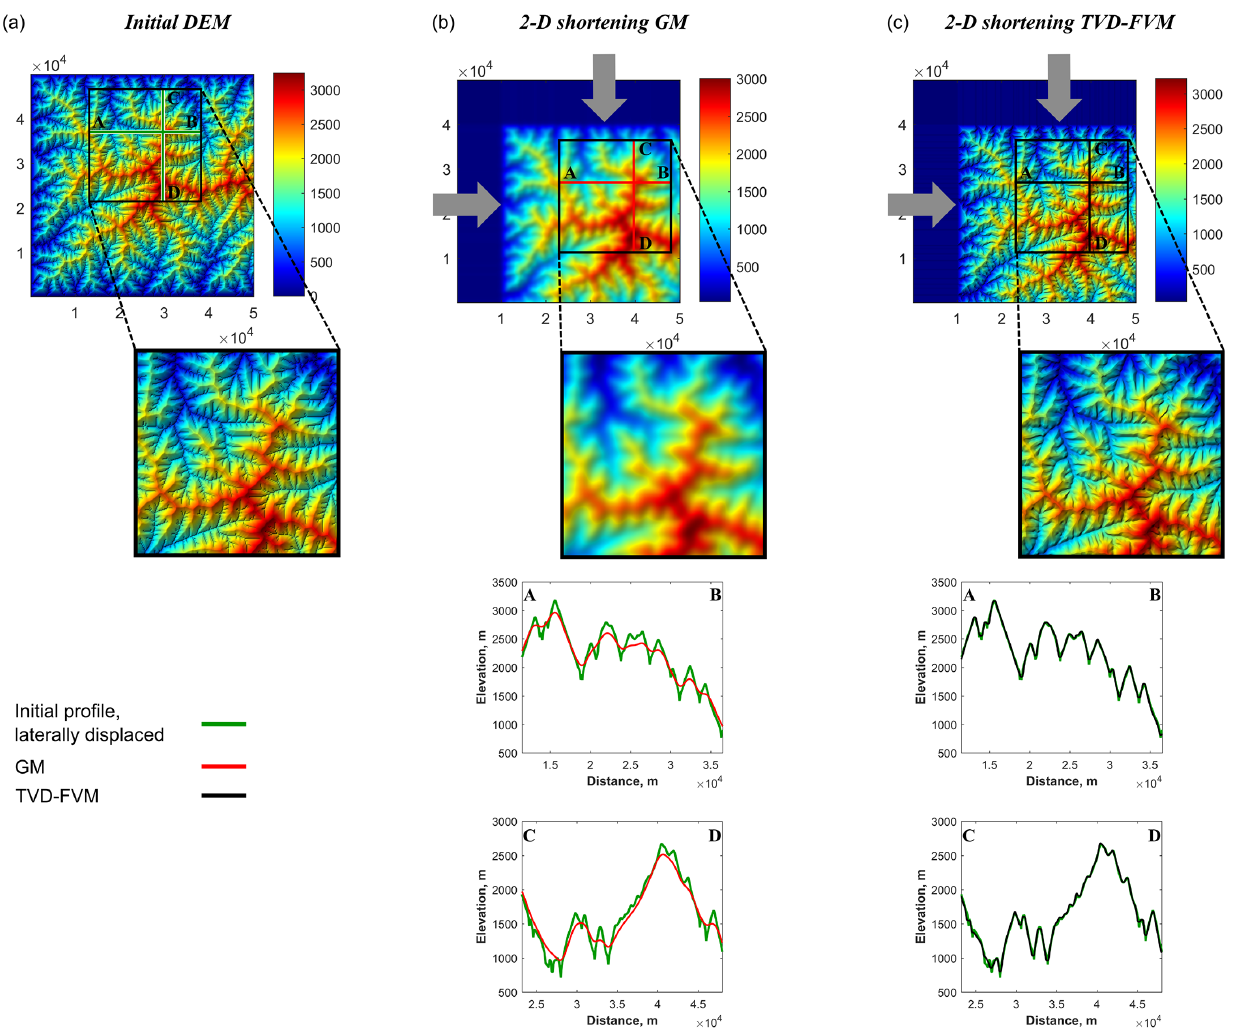
Figure 9. Impact of numerical schemes when simulating horizontal shortening on a fixed grid. The simulations are performed at a spatial resolution of 50m and a CFL of 0.5. (a) Extract from synthetically produced DEM from Fig. 2. (b) Horizontal shortening in two directions simulated with a two-dimensional explicit first-order GM. The green lines represent transects of the theoretically unchanged topography after lateral displacement. The red lines represent transects of the topography produced with the GM. (c) Horizontal shortening in two directions simulated with a two-dimensional explicit flux-limiting TVD-FVM (represented by black